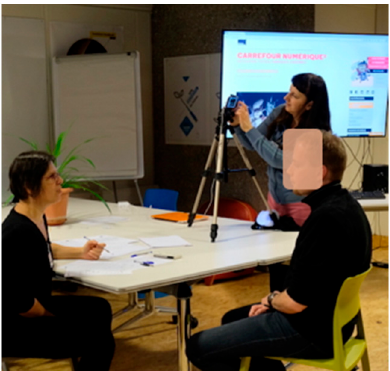
Figure 3. Visitors interviews, Cité des Sciences, (2017). Photo: Anne Charignon ©.